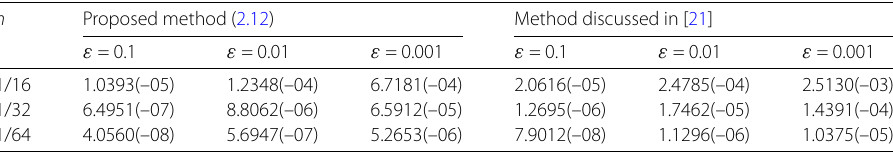
Table 4 Problem 8.4: The maximum absolute errors